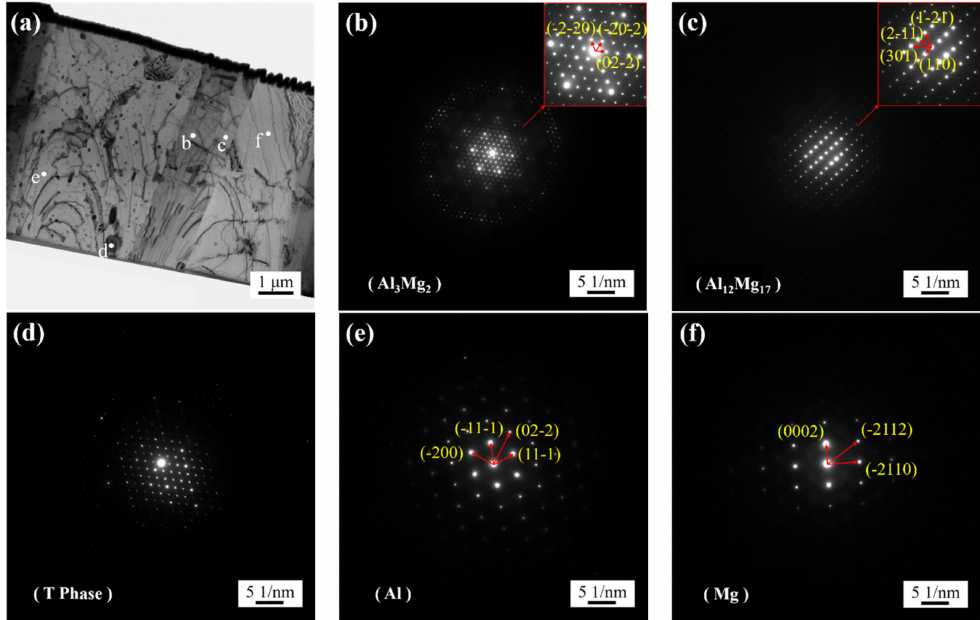
Figure 7. TEM diffraction pattern at location BOT: ( a ) diffraction location (corresponding to Figure 4a), and ( b – f ) diffraction pattern at locations b–f in ( a